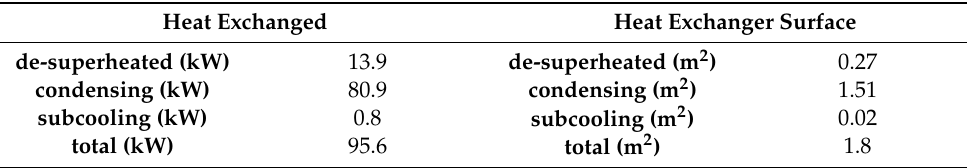
Table 5. Heat exchanged and exchange surface.